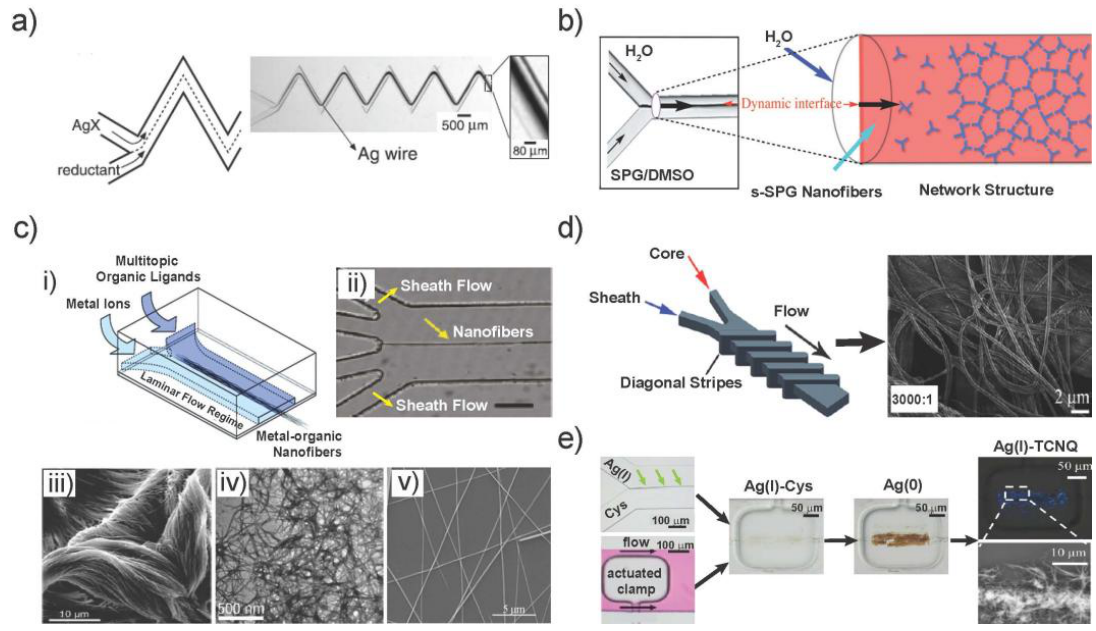
Figure 1. Synthesis of different 1D anisotropic materials using continuous flow method on various microfluidic devices. ( a ) Formation of a silver wire at a fluid-fluid-interface of two co-flowing reagent solutions, a dissolved silver salt and a reductant. ( b ) Mechanism of the formation of the network structure at the dynamic interface; s-SPG nanofibers are continuously supplied to the end of the network structure at the Y-junction point. Thus, the network structure extends along the flow. ( c ) ( i ) Scheme for formation of a metal-organic structure by co-laminar flow of two solutions with either metal or organic precursors. A reaction will take place at the fluid-fluid-interface and result in the formation of a nanoscale structure. ( ii ) Optical microscope images demonstrating the centered assembly along the main channel. ( iii ) SEM image of Cu-Asp nanofiber bundles; ( iv ) TEM image of Ag-Cys nanofibers and ( v ) SEM image of Au-TTF NWs fabricated by the four-inlet microchip. ( d ) Schematics of fluids inside 5-diagonal groove sheath-flow devices (left) and the SEM image of circular PMMA fibers fabricated using this device at sheath-to-core flow-rate ratios of 3000:1; ( e ) Optical microscope images showing the assembly of Ag(I)-Cys at the interface of AgNO 3 and Cystein aqueous reagent streams (left top); the actuation of a pneumatic clamp in the channel with pink dye flow (left bottom); the formation of Ag(I)-Cys and Ag(0) and Ag(I)-TCNQ NWs (polarized image on right top and SEM image on right bottom). Images in Figure 1 are reproduced with permission ( a ) from [11], ( b ) from [34], ( c ) from [7,14], ( d ) from [12] (The Royal Society of Chemistry) and ( e ) from [38].